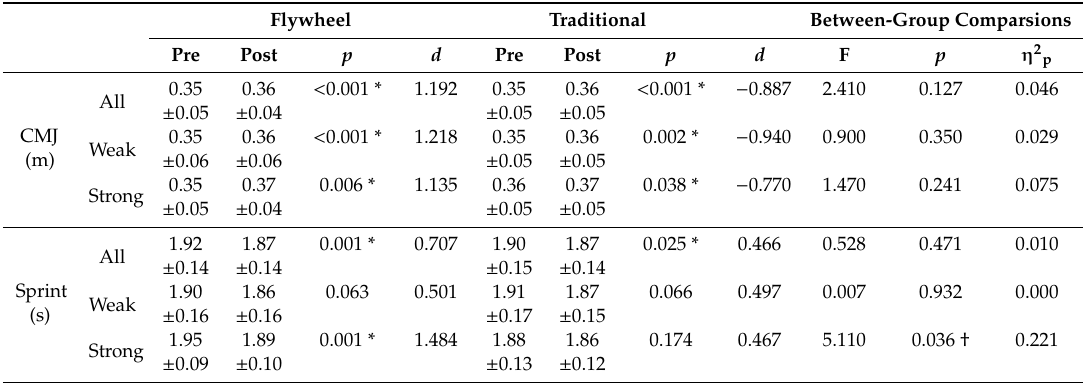
Table 1. Sprint and jump performance before and after the two conditioning activities. CMJ, countermovement jump. Flywheel Traditional Between-Group Changes Flywheel Traditional Between-Group Comparsions Pre